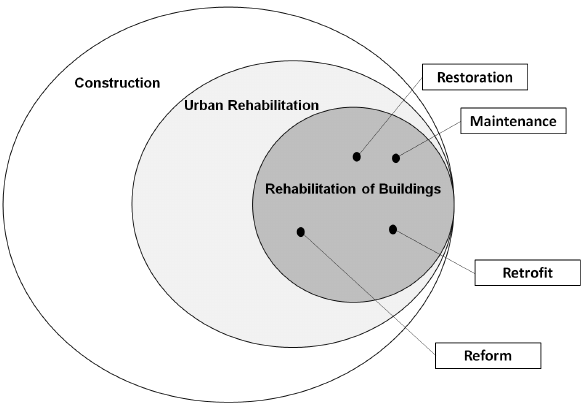
Figure 1: Rehabilitation of buildings in the civil construction sector and its activities